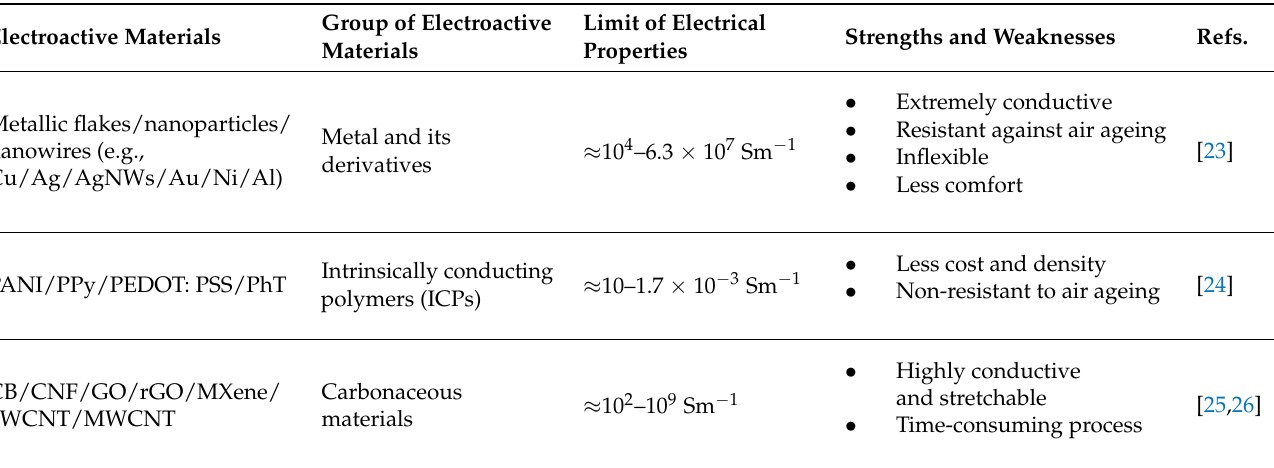
Table 1. Typically used electroactive materials and their properties for